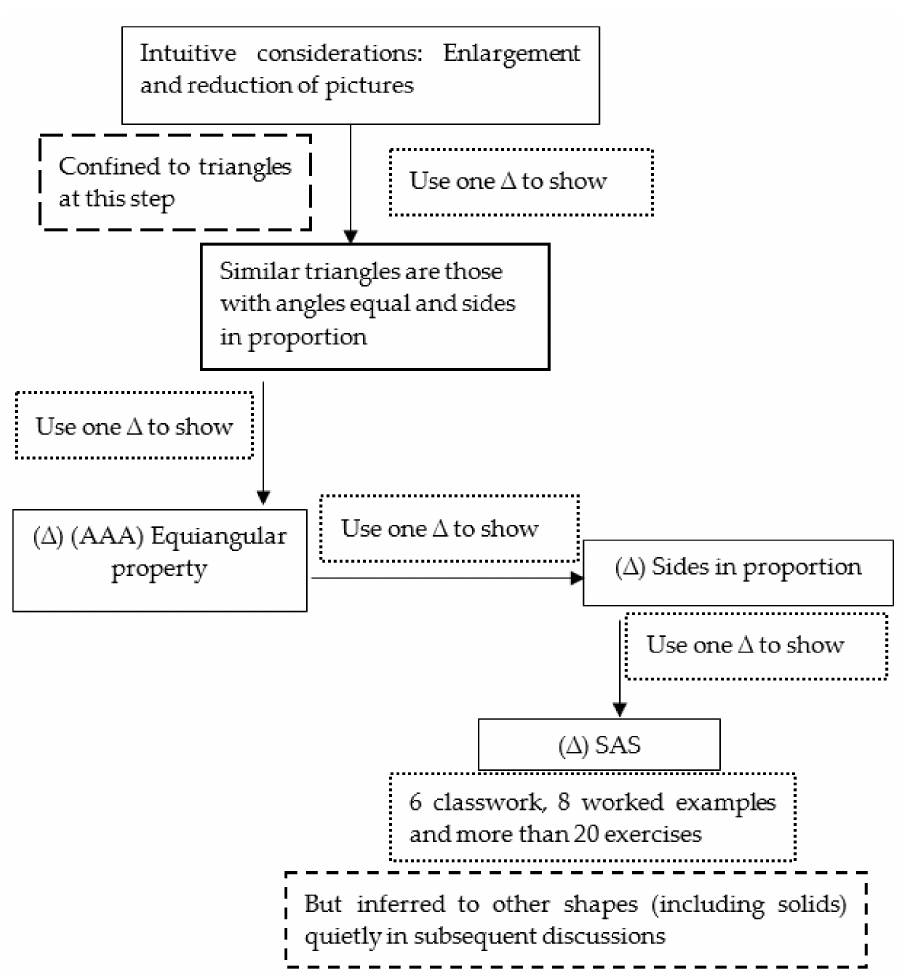
Figure 4. Introduction of similar figures in current textbooks